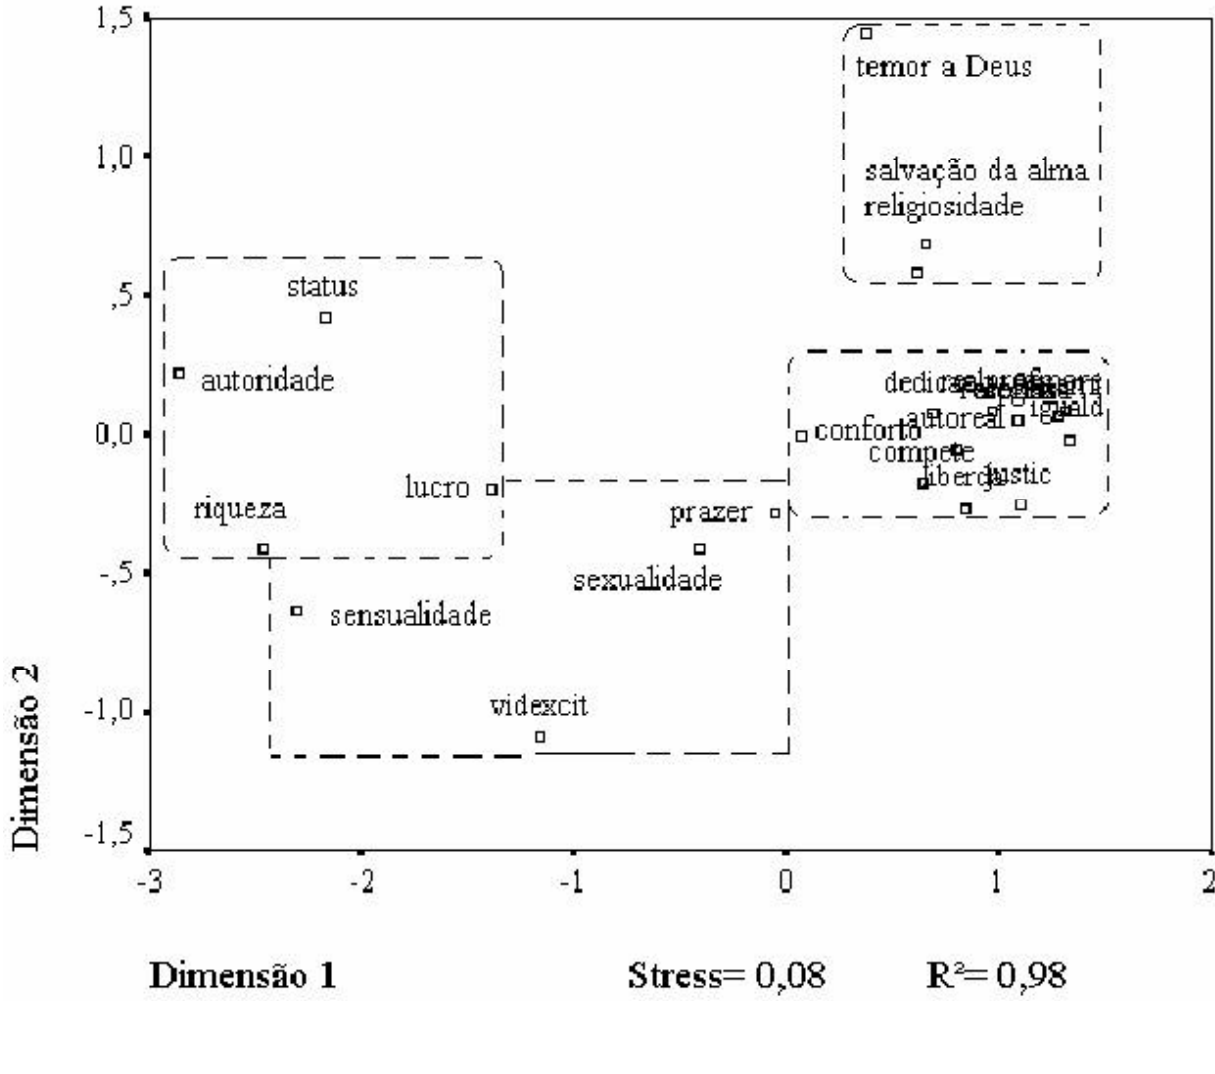
Figura 1 . Organização dimensional da estrutura valorativa dos adolescentes (MDS).